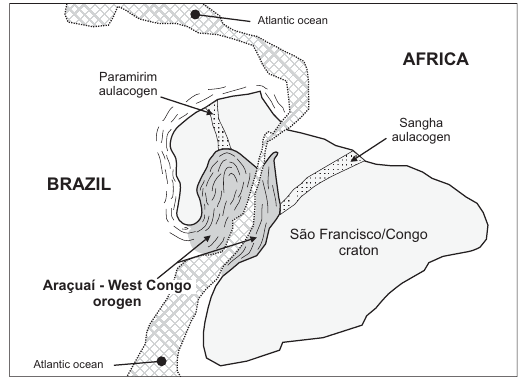
Fig. 1 – Actual coastline of South America and Africa in a schematic reconstruction of the western portion of Gondwana highlighting the São Francisco-Congo craton and the Araçuaí- WestCongoorogen. ModifiedfromPedrosa-Soaresetal.